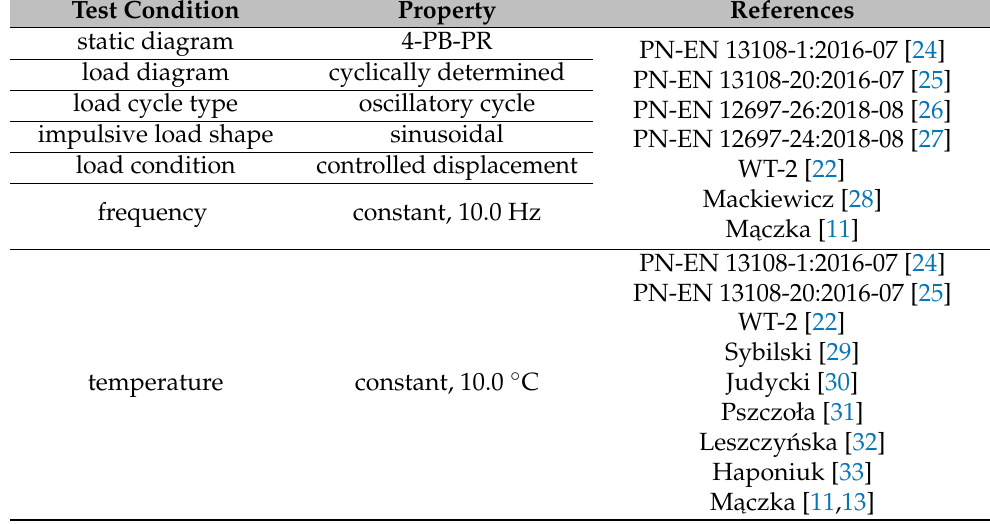
Table 2. General fatigue test conditions.